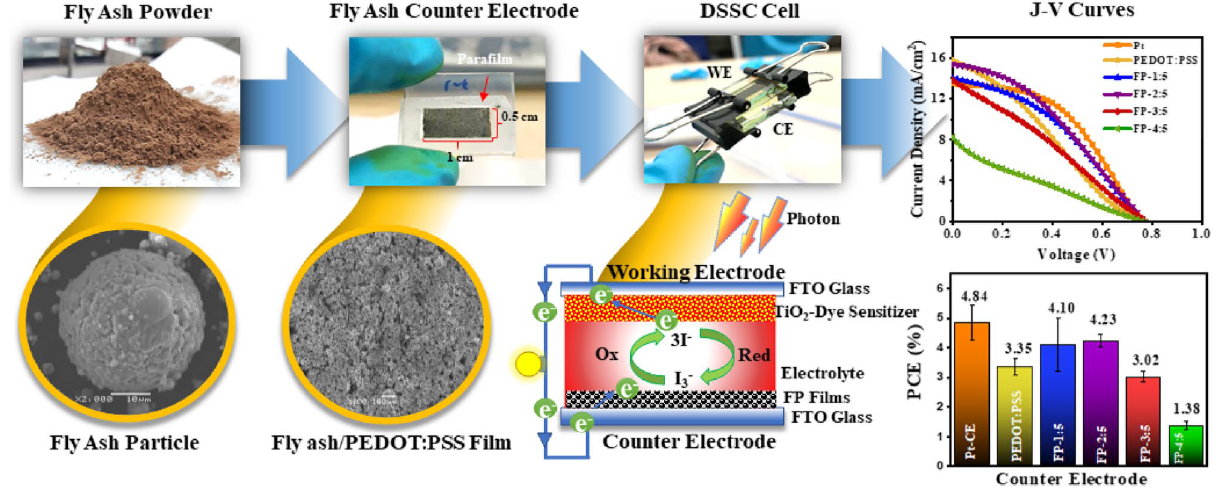
Figure 1. Schematic of the fly ash counter electrode and DSSC J-V